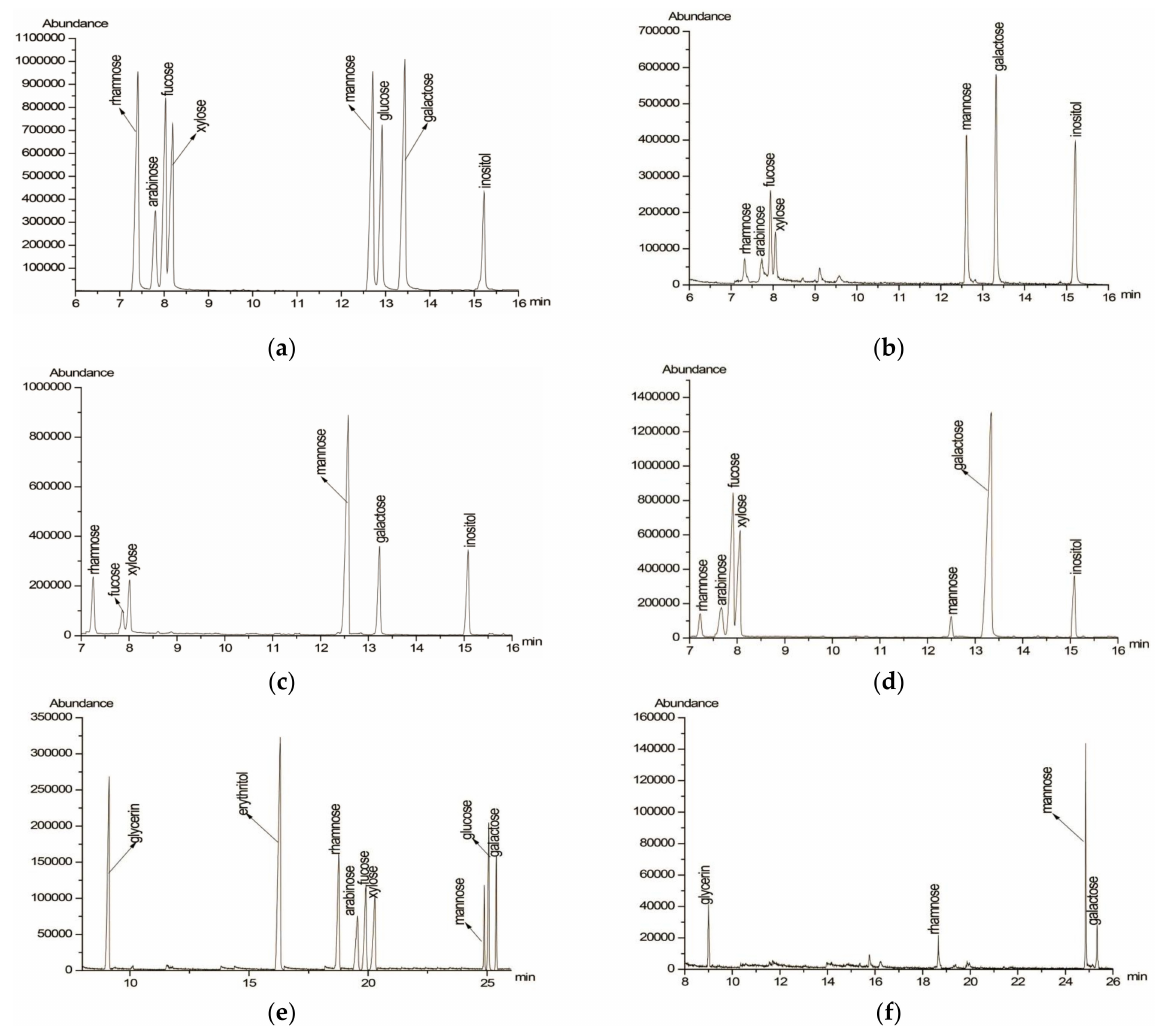
Figure 2. GC chromatograms of standard monosaccharides ( a ); monosaccharide compositions of PAP-3 ( b ); monosaccharide compositions of PAP-3-I ( c ); monosaccharide compositions of PAP-3-O ( d ); standard monosaccharides, glycerol and erythritol ( e ); products of Smith degradation of PAP-3 ( f